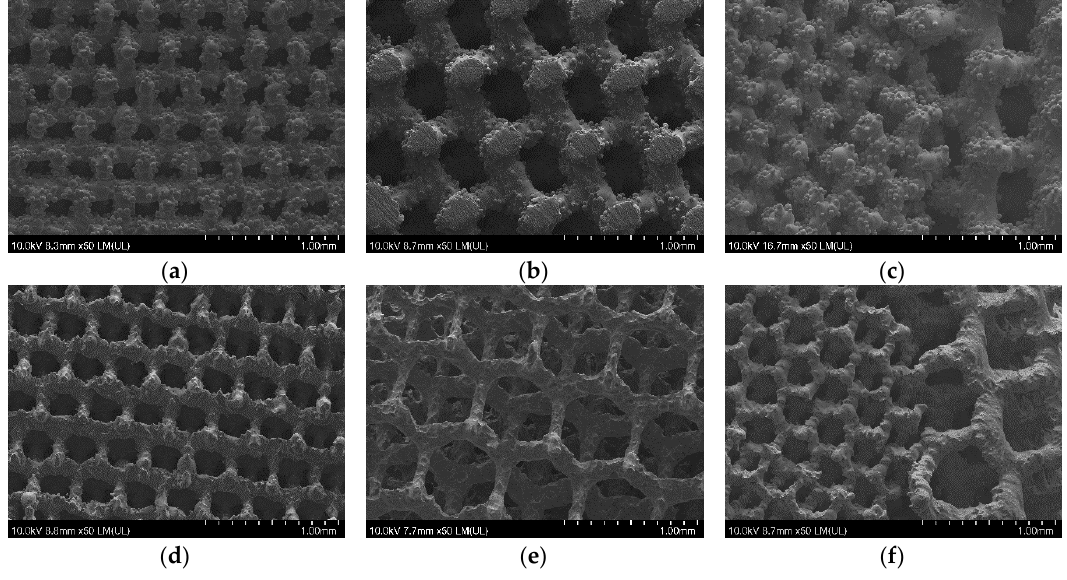
Figure 7. As made scaffolds with designed pores equal to 200 µm ( a ); 500 µm ( b ); 200 + 500 µm ( c ); and exemplary micrographs of scaffolds polished in HF/HNO 3 solutions for 6 min: 200 µm—2.0% HF/20% HNO 3 ( d ); 500 µm—1.3% HF/9.0% HNO 3 ( e ); 200 + 500 µm—2.2% HF/20% HNO 3 ( f ).